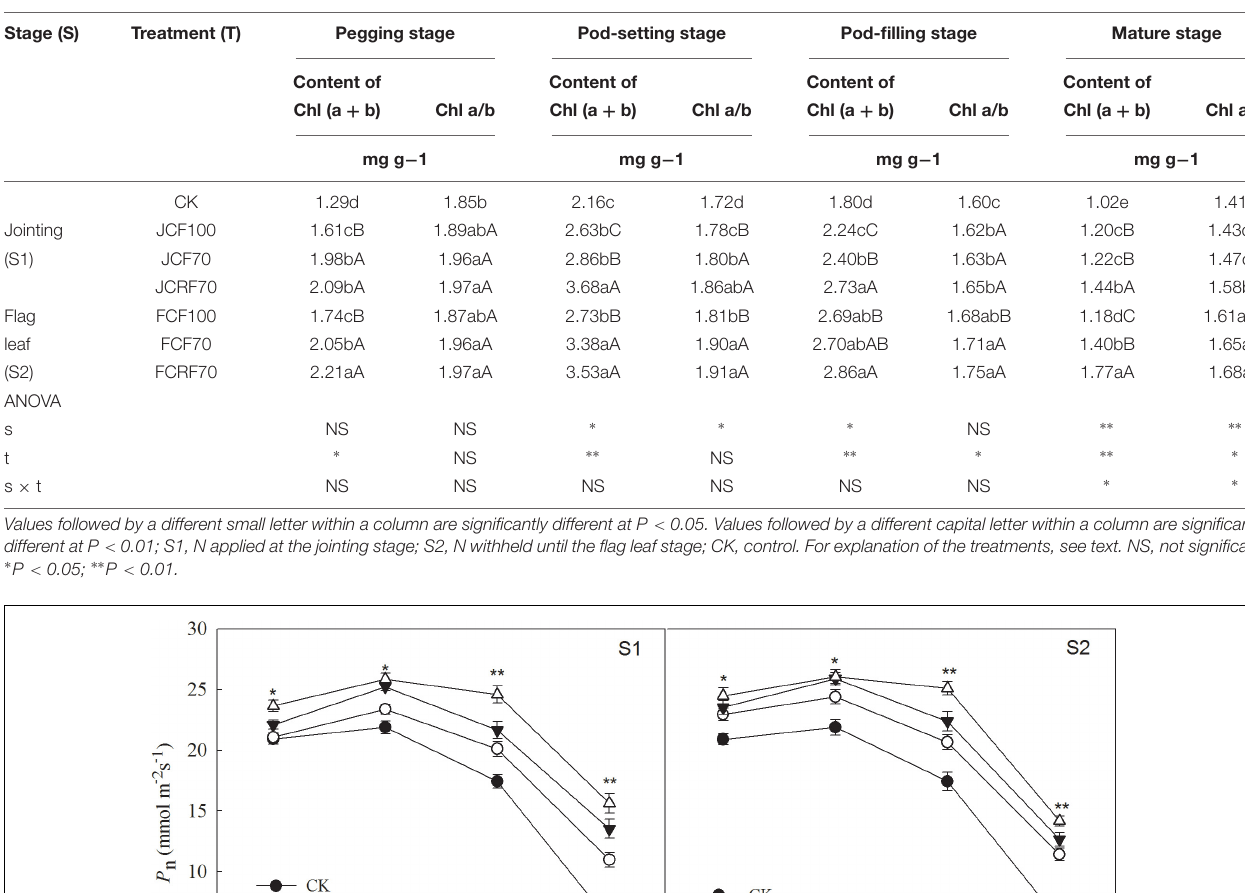
stage, and reached a maximum at maturity ( Figure 5 ). There were no significant year × stage × N treatment interaction